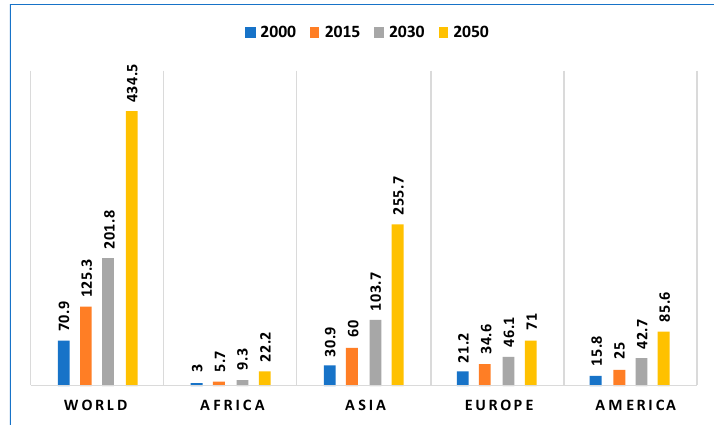
Figure 3. Numbers of persons (millions) aged over 80 years in the world in different years [1].